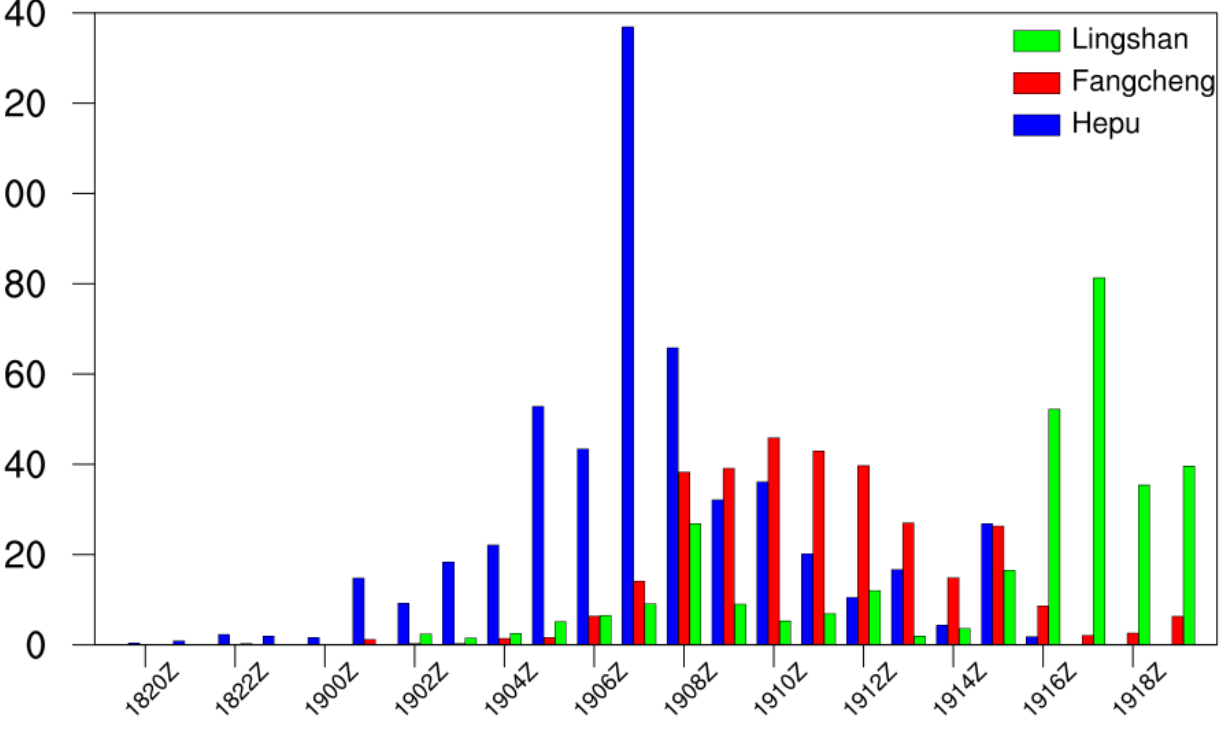
Figure 3. The variations in hourly precipitation at three rainstorm centers (i.e., Hepu, Fangcheng, and Lingshan) from 20BST 18th to 20BST 19th July.